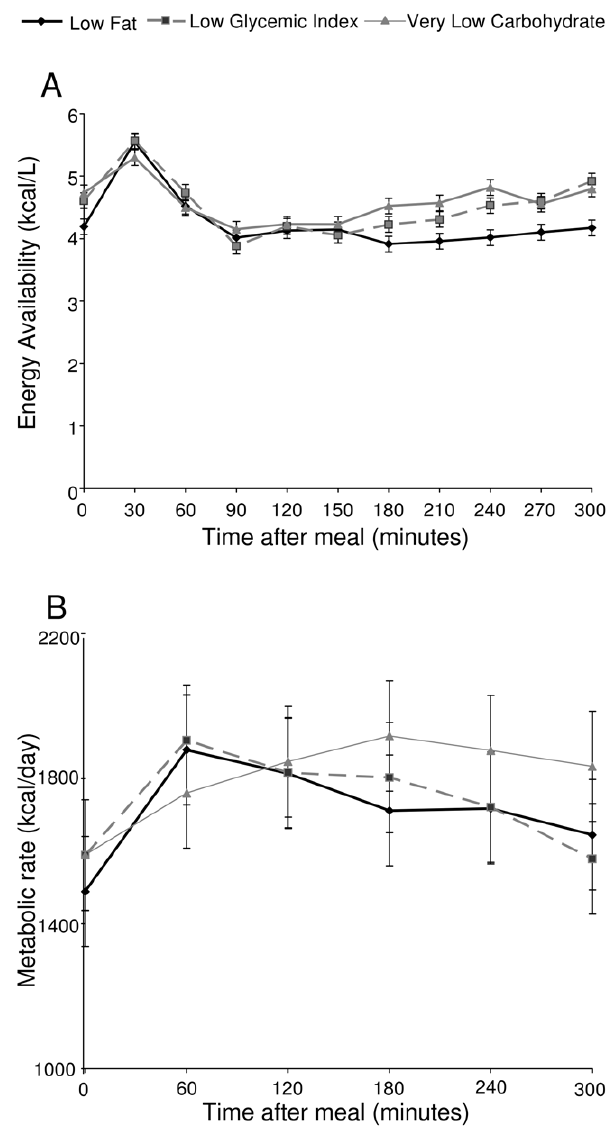
Figure 1. Postprandial energy availability (EA) (Panel A, kcal/L), and metabolic rate (Panel B, kcal/day). EA is calculated as the total energy densities of glucose, free fatty acids, and b -hydroxybutyrate. Error bars represent the standard error of the mean from fitted repeated-measures model.